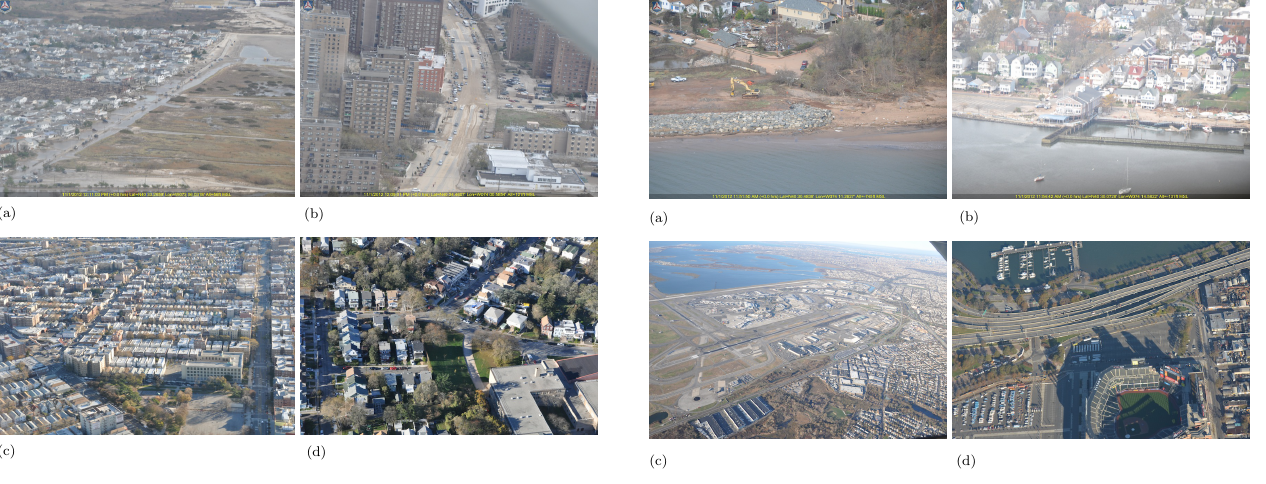
Fig. 10. (a) Flooding documented by the Civil Air Patrol but not estimated by FEMA. (b) Flooding documented by the Civil Air Pa- trol but not estimated by FEMA. (c) Flooding estimated by FEMA but not confirmed by the Civil Air Patrol. (d) Flooding estimated by FEMA but not confirmed by the Civil Air Patrol. Disagreement between Civil Air Patrol photos and FEMA evaluation for flooded ( a and b ) not flooded ( c and d